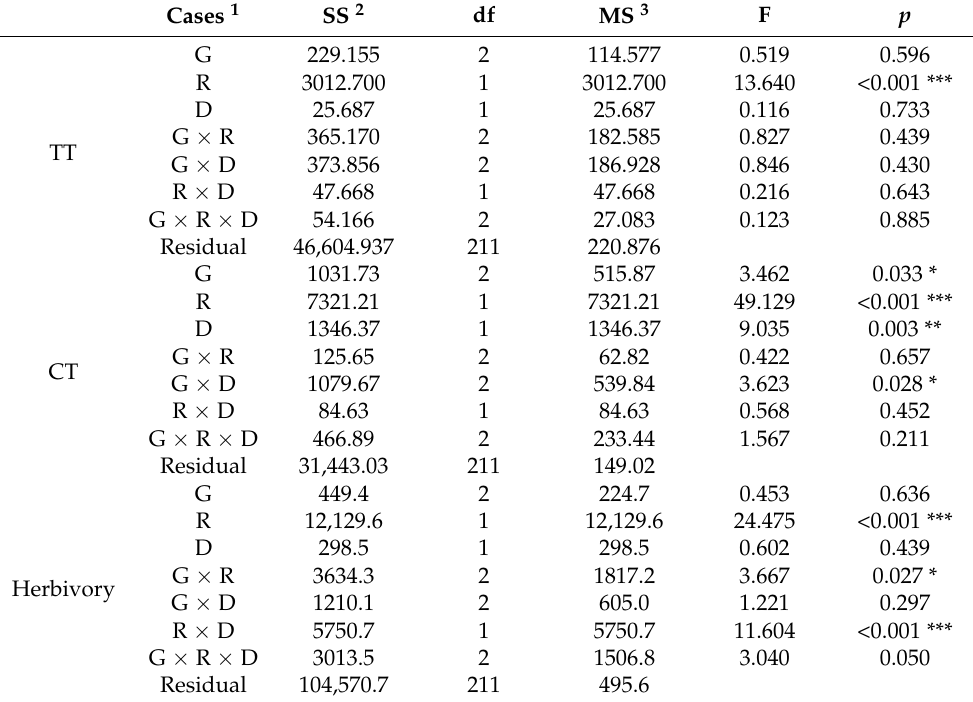
Table 3. Interaction effects (two-way ANOVA) of genotype, region, and forest density on chemical defense production and herbivore